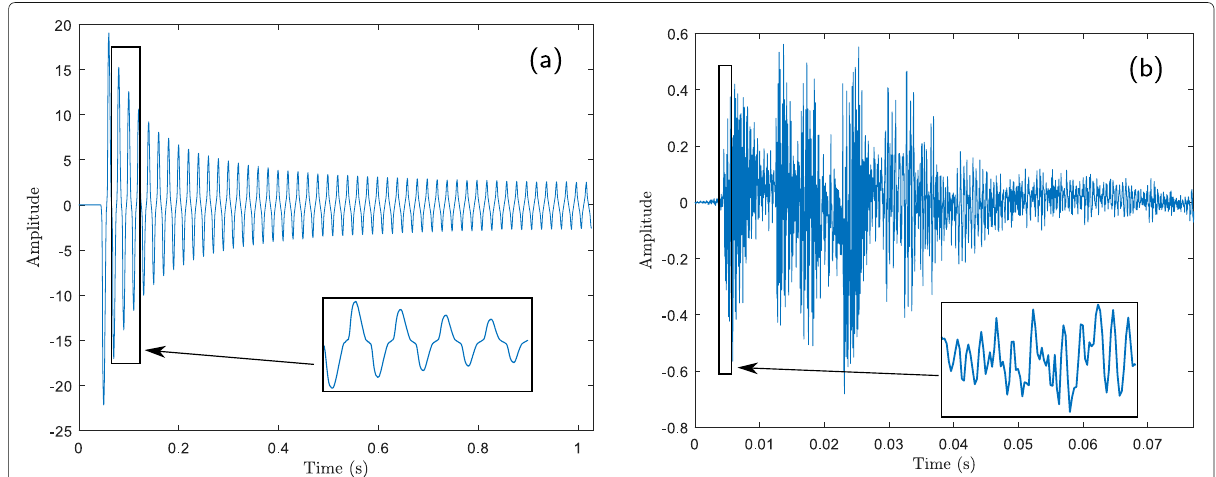
Fig. 1 Two examples of transients. a A (turn-on) transient of an electrical signal (drill) for which the superimposed damped sinusoids (SDS) model is inadequate, and b a transient of an audio signal (castanets) for which the SDS model is adequate. Note the non-stationary content of b and the quasi-stationary content of